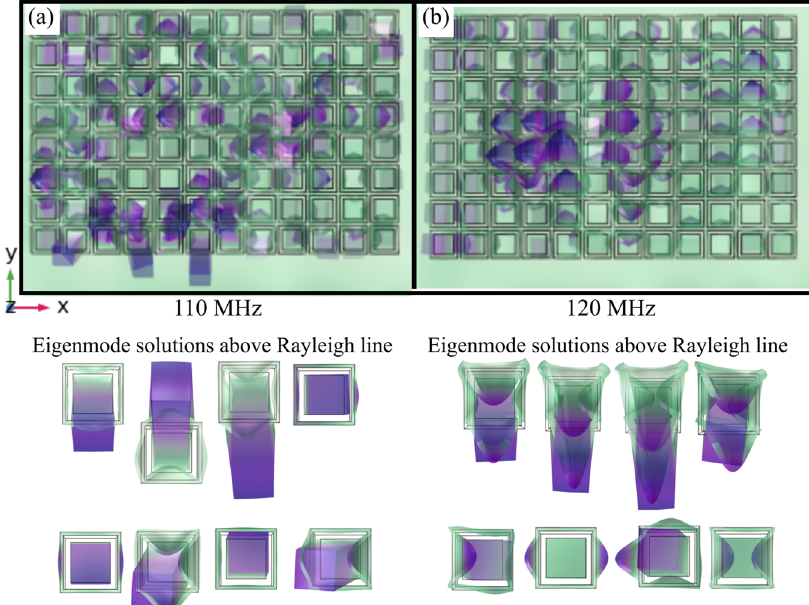
Fig. 4 Simulated solid displacements with deformations and eigenmodes. a and b Solid displacements and deformation showing the modes present in the array (Array#1) at 110 and 120 MHz, respectively. Below the main fi gures are the eigenmodes found above the Rayleigh line up to the fi rst 12 solutions taken from the eigenmode study at or close to the given frequency (see band diagrams Fig. 1 and Supplementary Fig. 4 for higher order modes). Data obtained using COMSOL Multiphysics ® 38